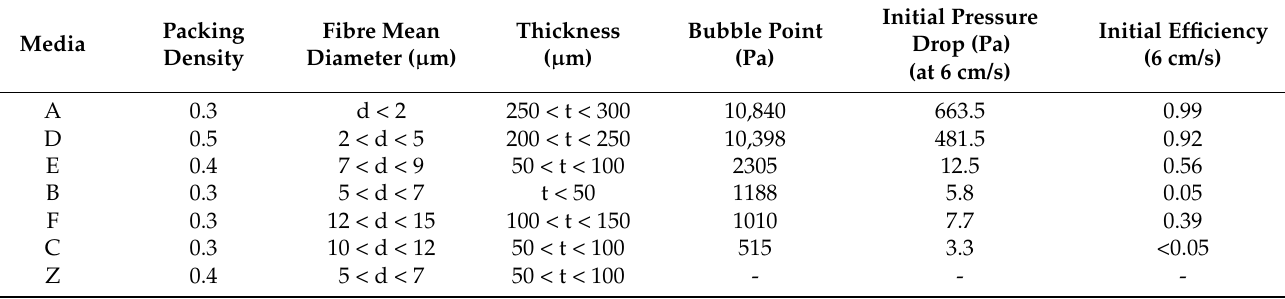
Figure 3. Scanning electron microscopy (SEM) image of a cross-section through the thickness of a multilayer media and its component monolayer media (A, B and C). Table 2. Characteristics of different monolayer metallic media.